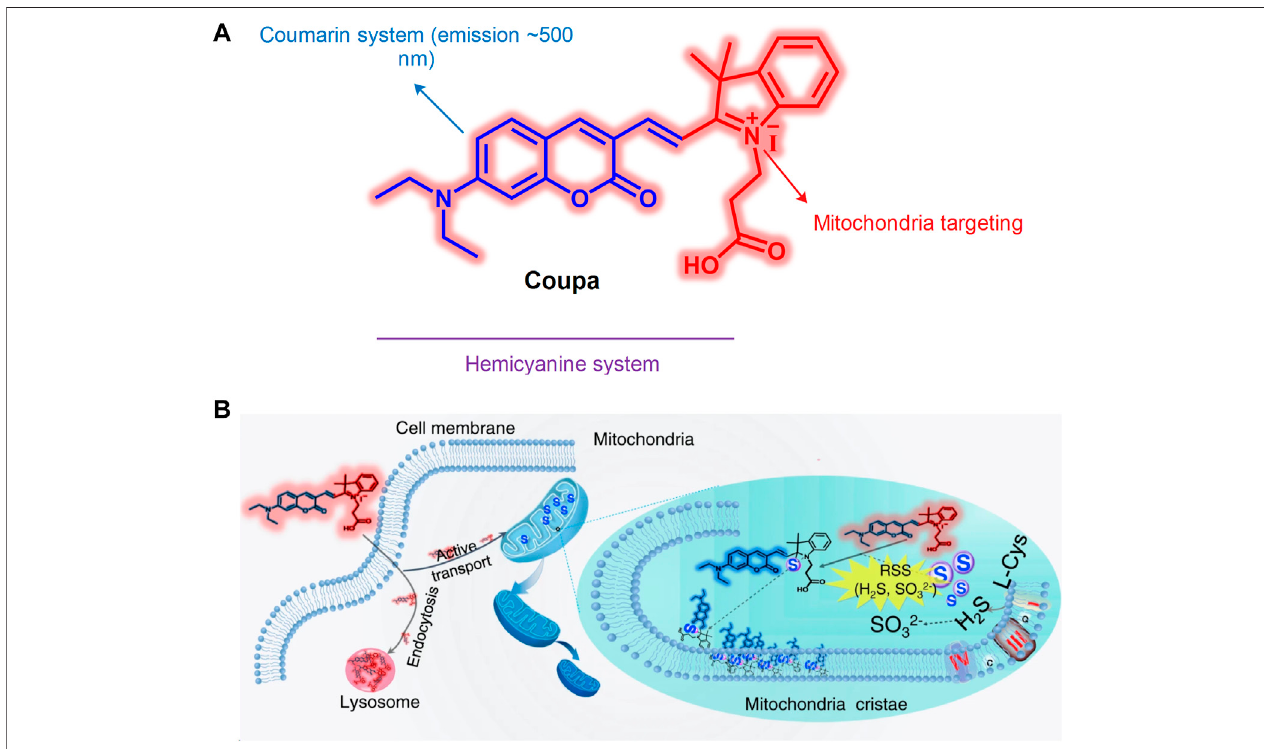
FIGURE 14 | The structure and action mechanism of probe Coupa (Qixin et al., 2020). (A) The chemical structure of Coupa; (B) The mitochondria- and lysosome- staining mechanisms of Coupa.